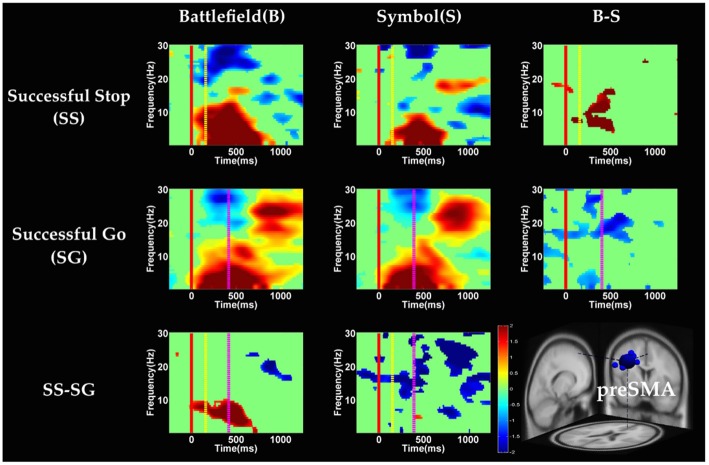
The event-related spectral perturbation (ERSP) images of preSMA cluster under inhibitory control. Red solid line: onset of the go stimulus; yellow dash line: onset of the stop signal; purple dash line: onset of response; color bars indicate the magnitude of the ERSPs; statistical threshold at p < 0.01.